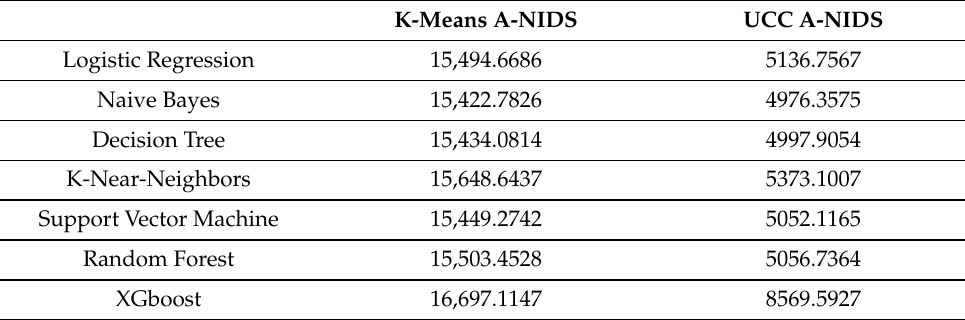
Table 6. Overall processing time of k-means A-NIDS and UCC A-NIDS (in